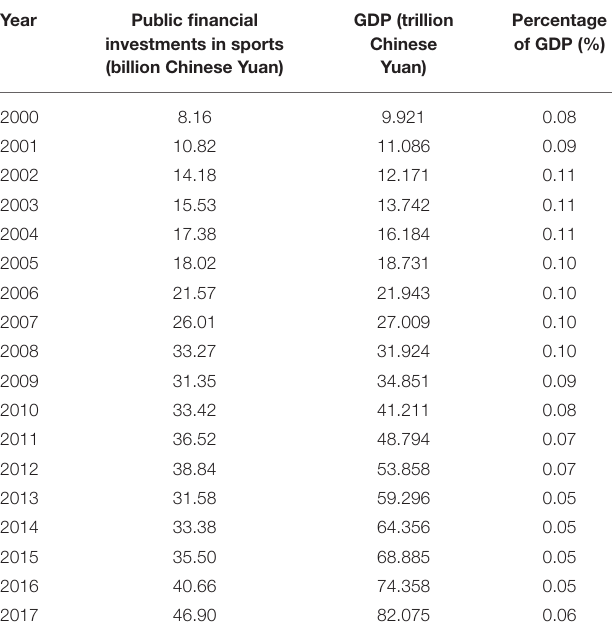
TABLE 1 | List of China’s public financial investments in sports as a percentage of gross domestic product